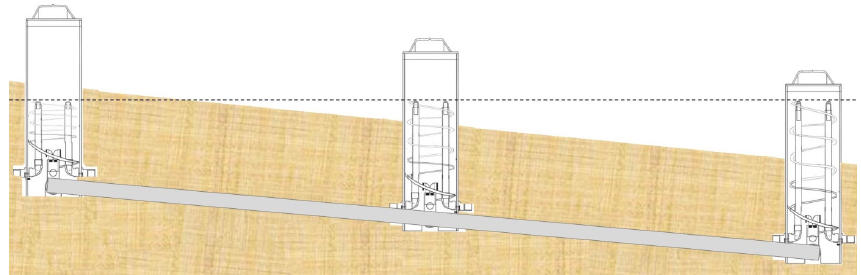
Figure 6. OPSIS can ensure equal discharge on sloping land.